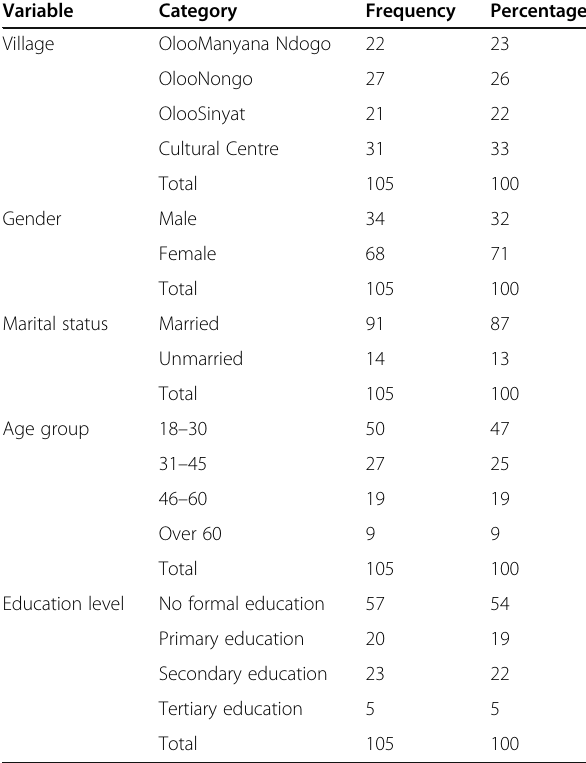
Table 1 Demographic characteristics of